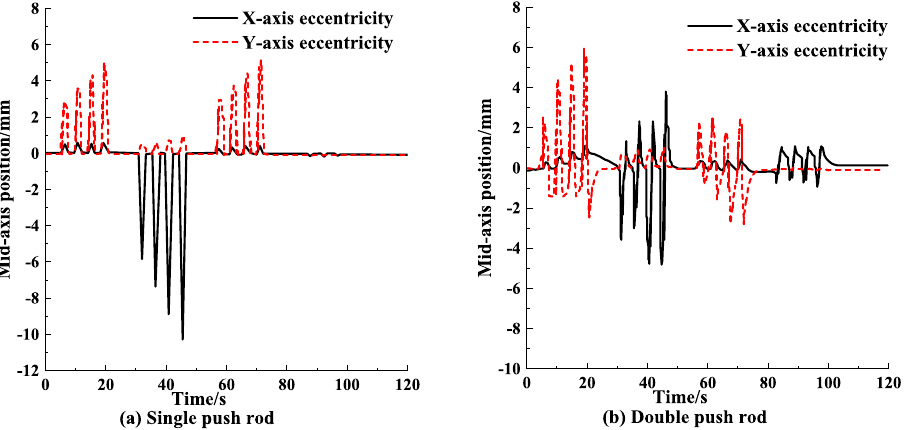
Figure 14. The displacement of the mid − axis of the single push rod support adjustment mechanism, double push rod − double spring support adjustment mechanism across the well wall deposit and casing wear.